Question: Write a caption explaining this figure to a reader.
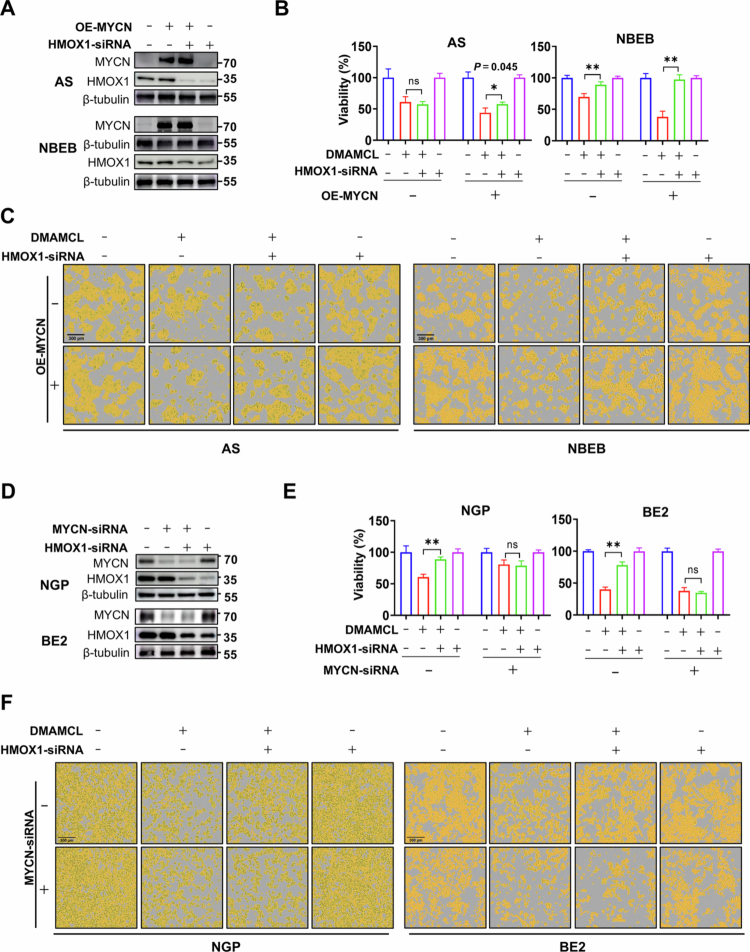
Answer: HMOX1-mediated DMAMCL-induced cell death exhibits MYCN-associated susceptibility. (A) HMOX1 and MYCN protein expression levels in AS and NBEB following transfection with either MYCN -overexpressing plasmid or empty vector, in combination with HMOX1 -siRNA or control-siRNA. (B) Cell viability was analyzed between HMOX1- siRNA + DMAMCL group and the DMAMCL-alone treatment group in AS and NBEB cells transfected with or without MYCN -overexpressing plasmid. (C) Representative images of cells transfected with HMOX1- siRNA or control-siRNA followed by DMAMCL treatment in AS and NBEB cells transfected with or without MYCN -overexpressing plasmid. Scale bar, 300 μm. (D) HMOX1 and MYCN protein expression levels in NGP and BE2 following transfection with MYCN -siRNA or control-siRNA, in combination with HMOX1- siRNA or control-siRNA. (E) Cell viability was analyzed between HMOX1 -siRNA + DMAMCL group and the DMAMCL-alone treatment group in NGP and BE2 cells transfected with or without MYCN -siRNA. (F) Representative images of cells transfected with HMOX1- siRNA or control-siRNA followed by DMAMCL treatment in NGP and BE2 cells transfected with or without MYCN -siRNA. Scale bar, 300 μm. Data were represented as mean ± SD, n = 3 independent biological replicates. * P < 0.05, ** P < 0.01, non-significant (ns).